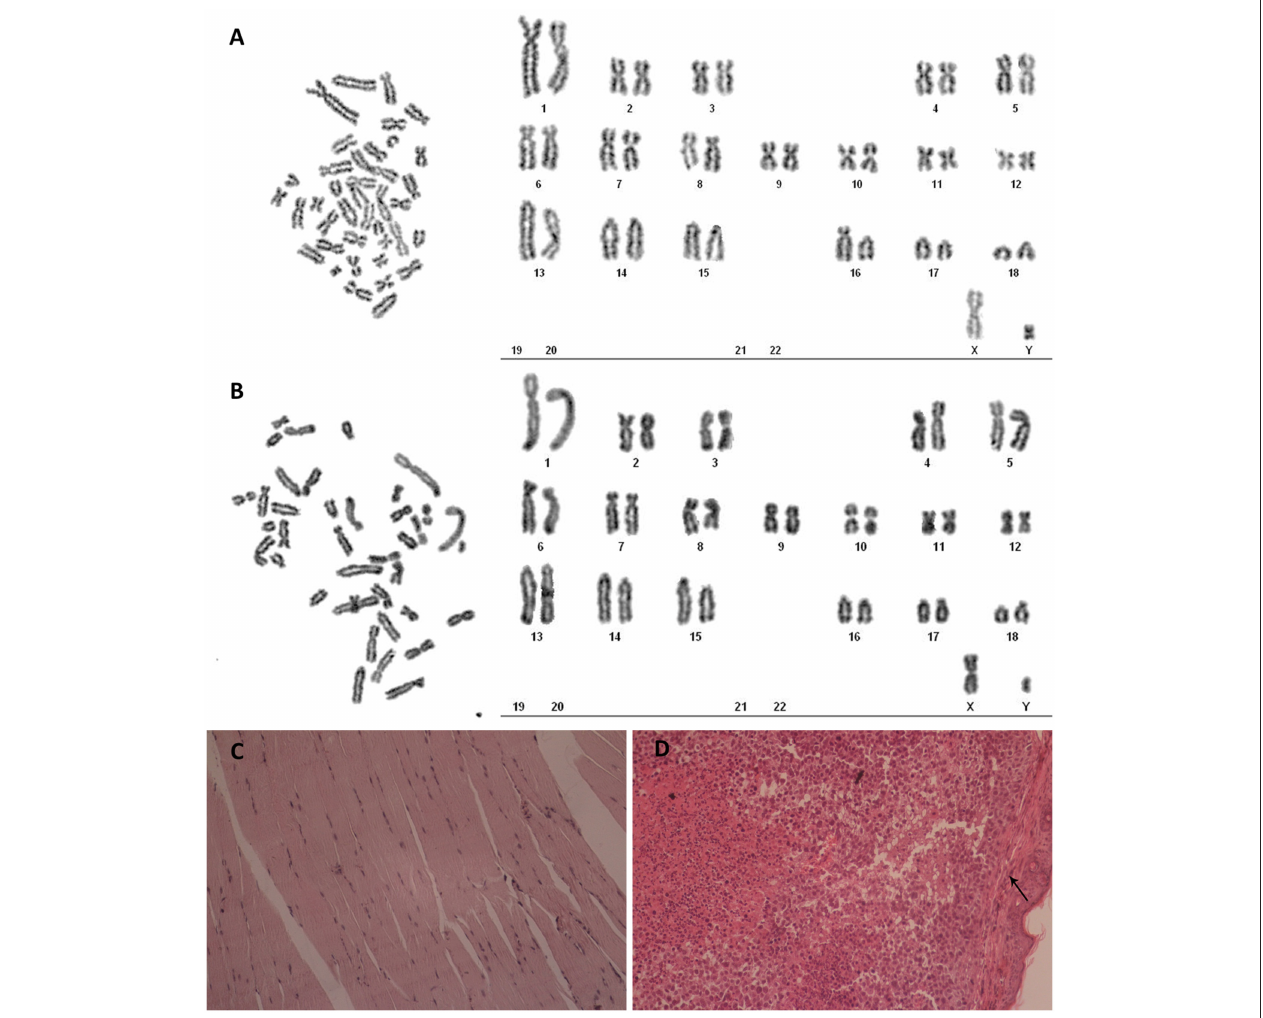
FIGURE 4 | Analysis of karyotype and tumorigenicity in hTERT-POMECs. (A,B) Karyotype analysis of third passage POMECs and 100th passage hTERT-POMECs. They both showed normal diploid numbers of chromosomes, 2n = 36 + XY pattern. (C,D) Tumorigenicity assays. Eightieth passage hTERT-POMECs and HeLa cells were injected subcutaneously into nude mice. One month later, the hTERT-POMECs group did not form tumors, and histological examination revealed a normal tissue structure at the site of hTERT-POMECs injection ( C , × 100 magnification). However, HeLa cells formed tumors under the skin (the black arrows indicate the skin), which displayed high nuclear/cytoplasmic ratios and irregular dense tumor cell invasion ( D , × 100